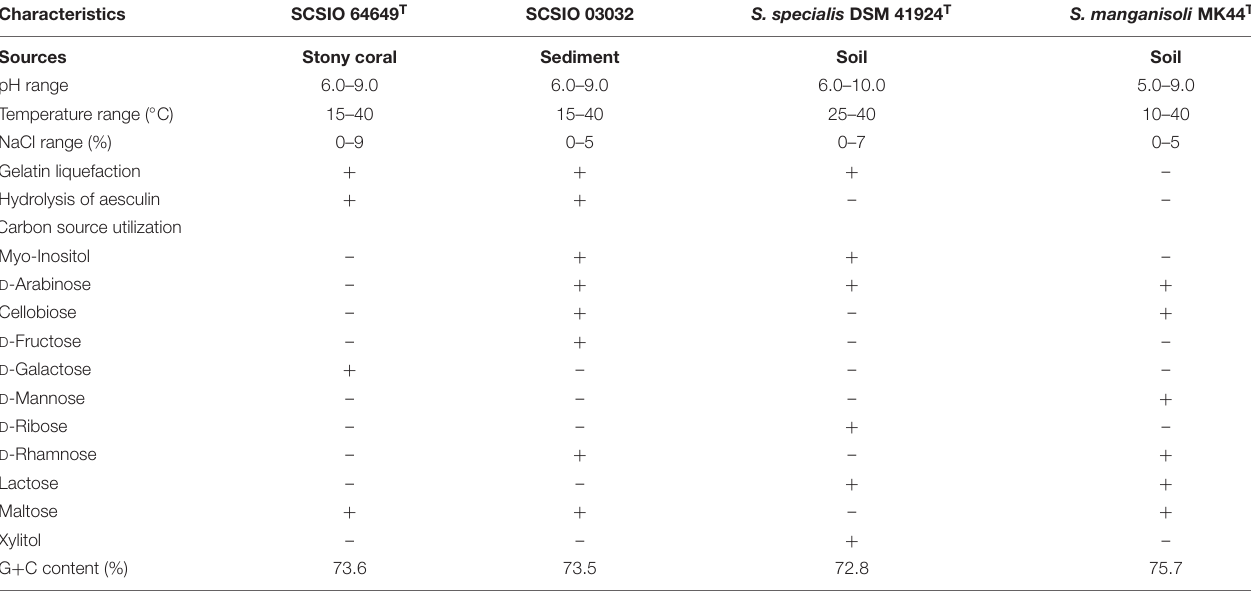
TABLE 2 | Phenotypic properties that distinguish strains SCSIO 64649 T and SCSIO 03032 from their closest phylogenomic relatives. Characteristics